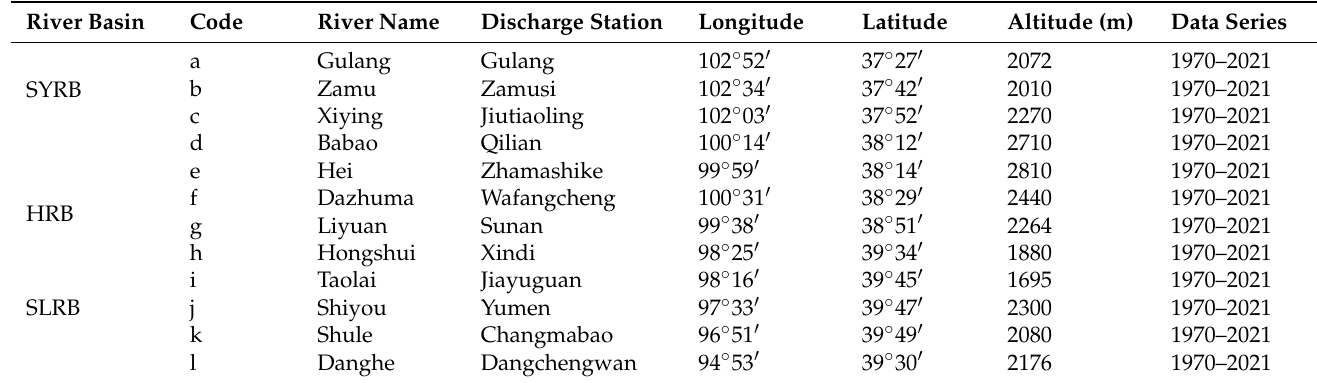
Table 1. Basic information on hydrological stations/catchments.